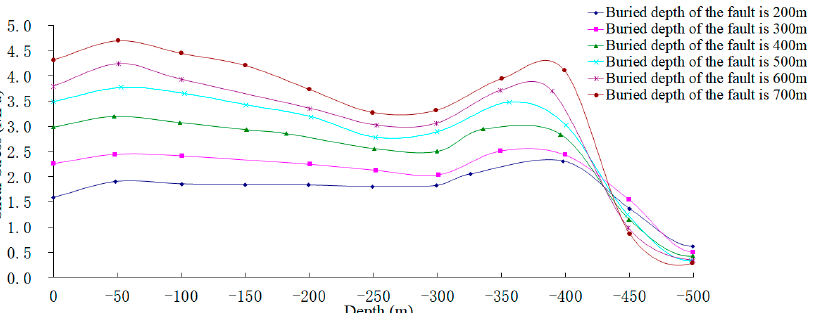
Figure 11. The shear stress distribution of the fault plane under various buried depths of the upper boundary of the fault. The principal stress difference distribution of fault hanging wall rock at the intersec- tion of the monitoring line and the fault under the conditions of different upper boundary burial depths of the fault, as shown in Figure 12. The maximum and minimum principal stresses in the hanging wall of the fault are larger than those in the footwall, and the dif- ference between the maximum and minimum principal stresses grows with the upper boundary burial depth of the fault, showing that the fault contributes to a greater barrier effect on stress field propagation.